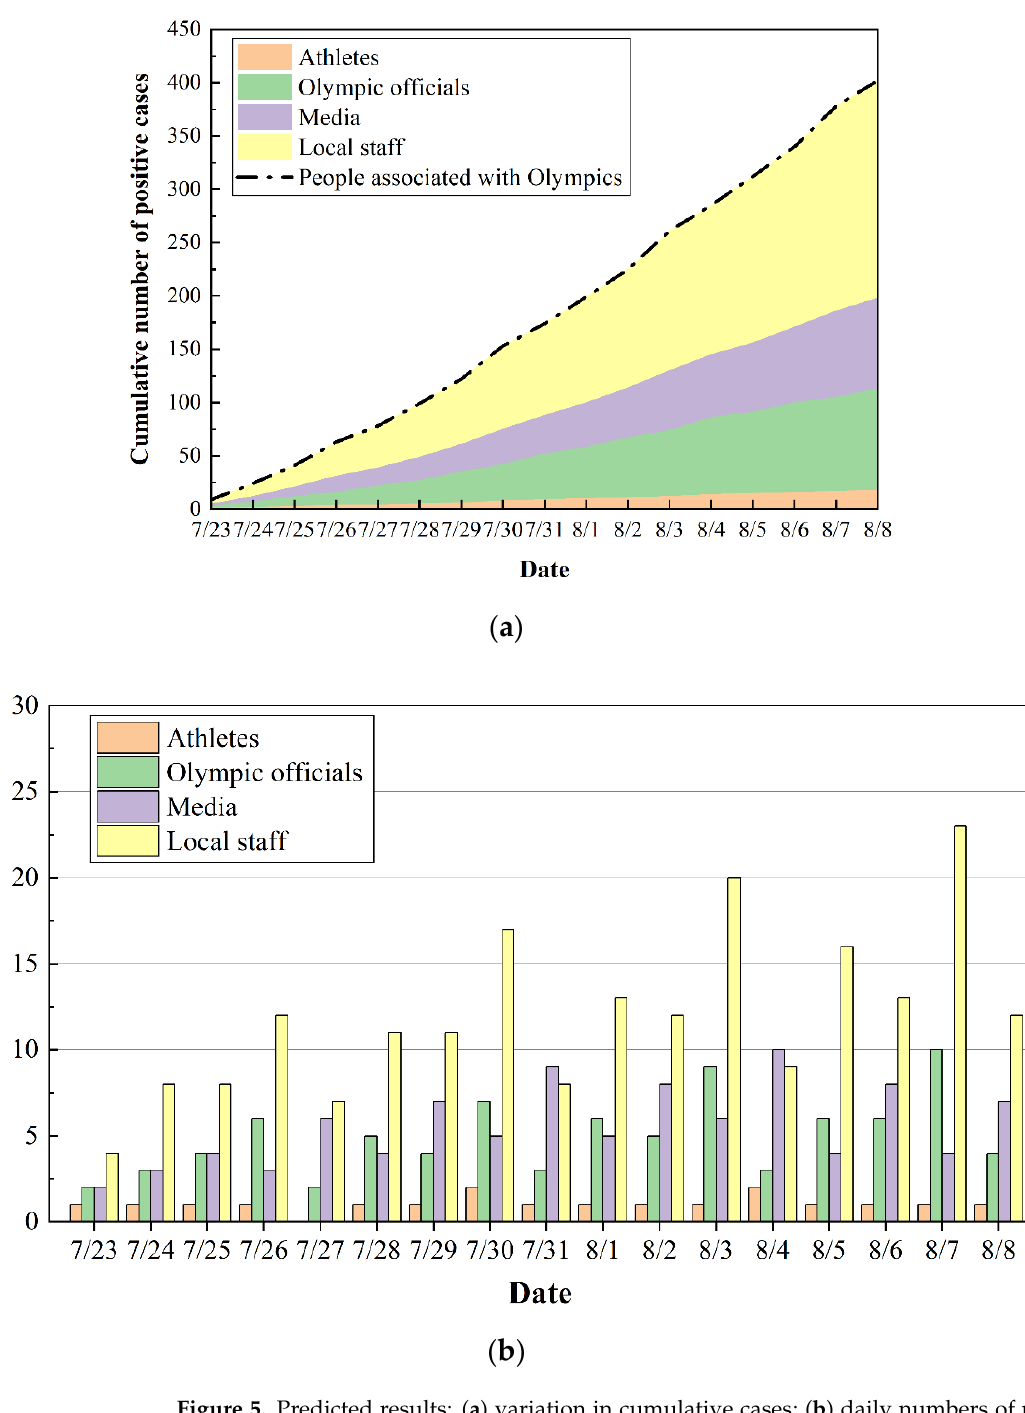
Figure 5. Predicted results: ( a ) variation in cumulative cases; ( b ) daily numbers of new cases for people in different